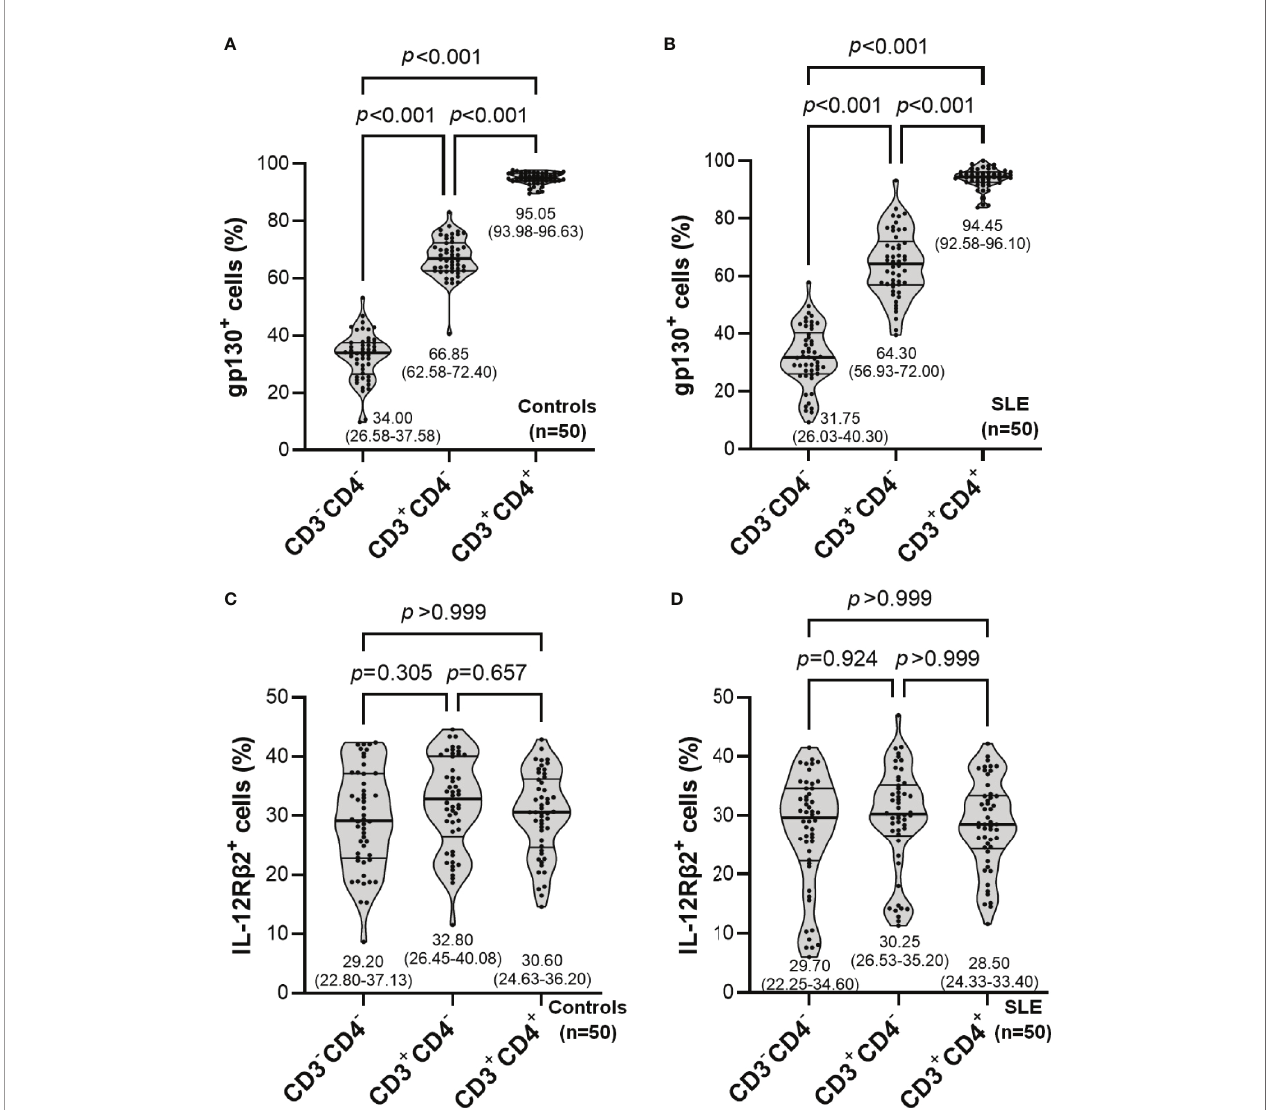
FIGURE 3 | Comparisons of the proportion of gp130 + (A, B) or IL-12RB2 + (C, D) cells in lymphocyte subpopulations within controls (n=50) or SLE patients (n=50). The inset numbers below each violin plot represent median